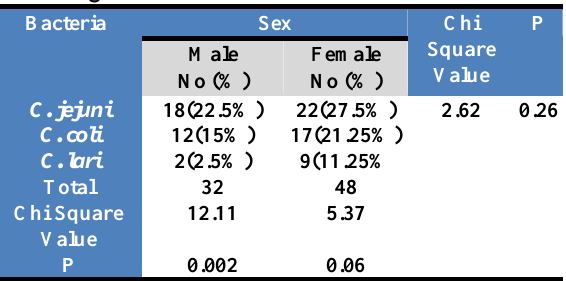
Table, 6: Isolation rates of Campylobacter spp according to sex of animals.